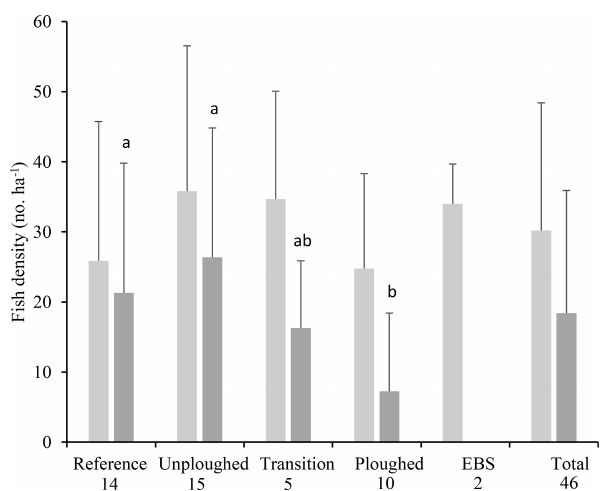
Figure 4. Total fish (light gray) and I. meadi (dark gray) density (mean and standard deviation) from the 2015 OFOS transects by habitat type (timed images only) and for the entire dataset. The number of separate transects for each habitat type is given under its name. Letter symbols for each habitat indicate significant differ- ences in I. meadi density ( p < 0 . 05).